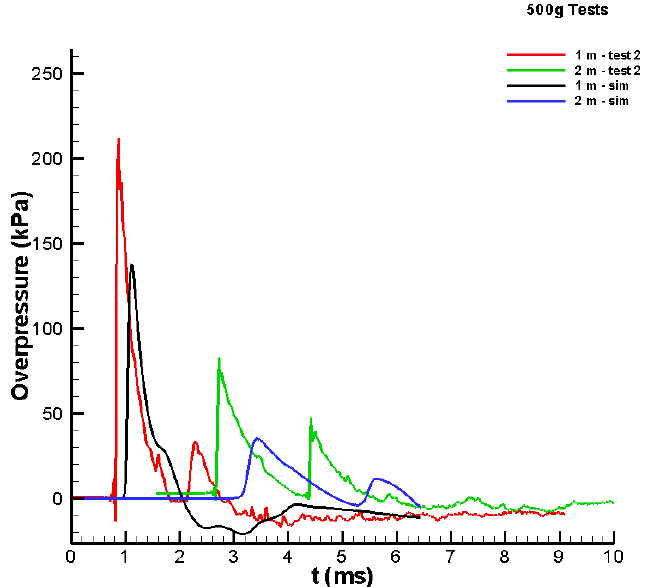
Figure 8. Comparison between test data and simulated values for the pressure versus time history for the 500 g Al/air cloud with a 52 cm diameter.